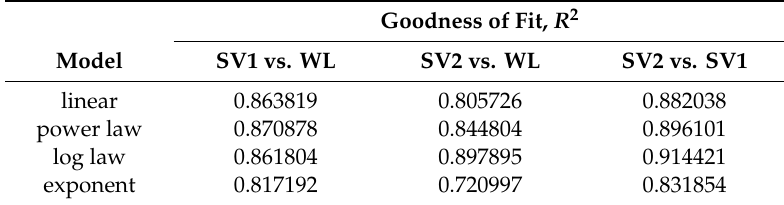
Table 3. Goodness of fit by di ff erent models at Wulilin Bridge.